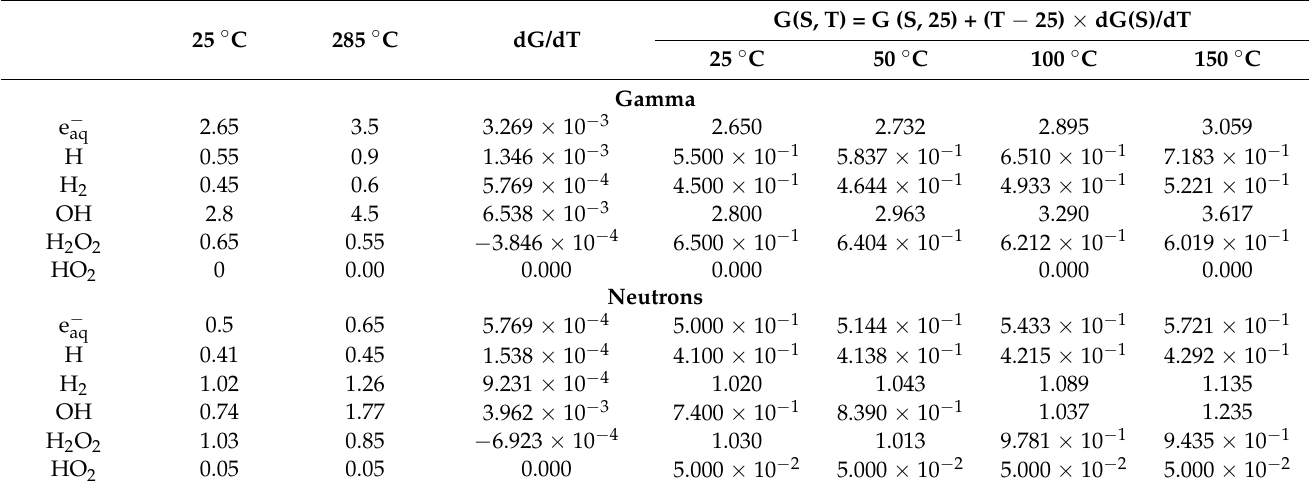
Table 17. G-values as a function of temperature for the radiolysis of water due to n and γ irradiation according to Christensen et al.